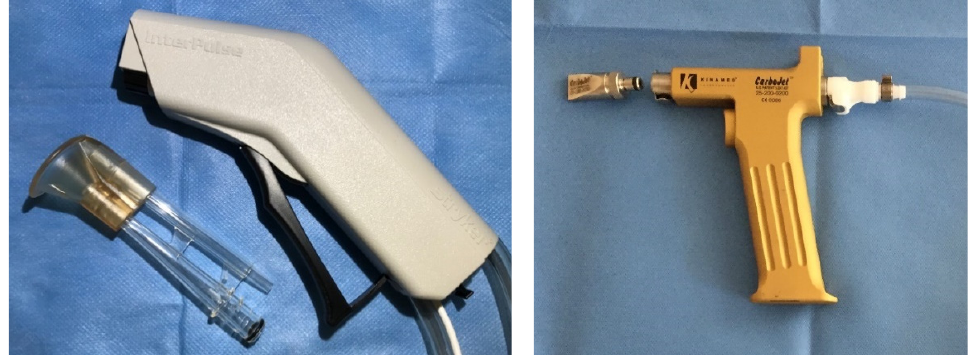
Figure 4. Pulsatile high-pressure saline lavage InterPulse with its bone cleaning tip ( left ) and carbon dioxide lavage CarboJet with its wide-angle-knee-nozzle ( right ).